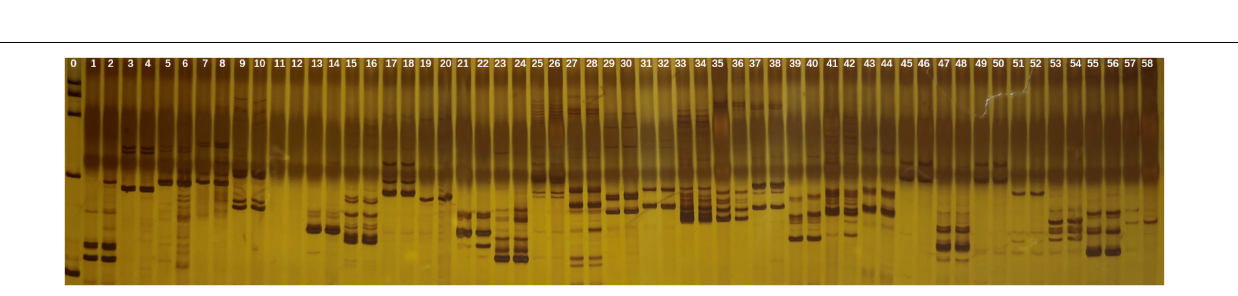
Frontiers in Plant Science |